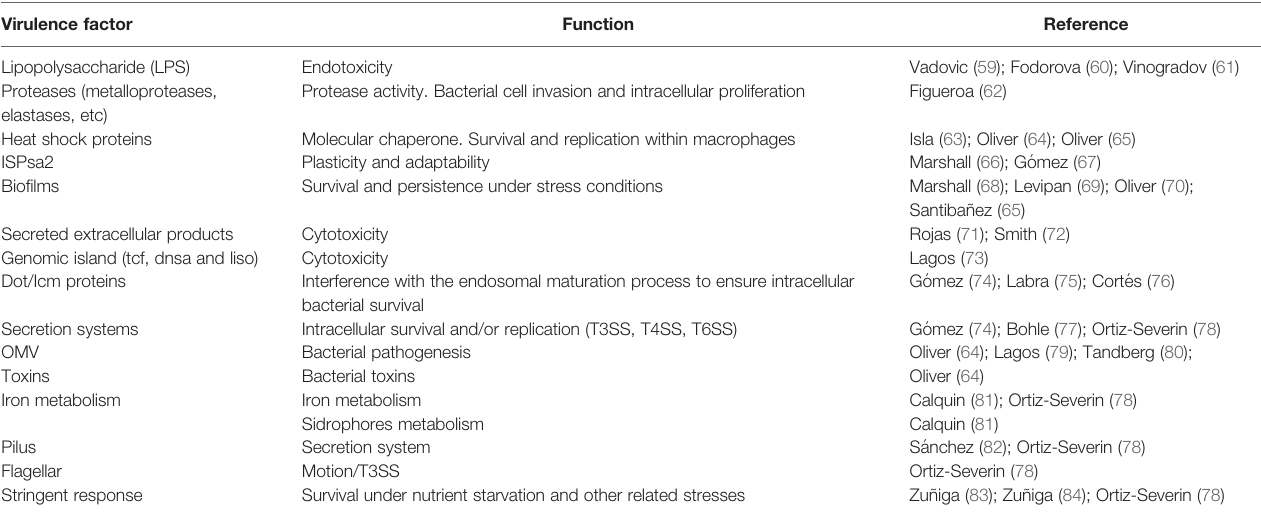
TABLE 2 | Virulence-related factors described in P. salmonis